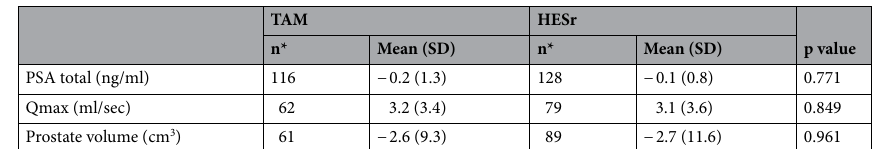
Table 3. Change from baseline to 6-month follow-up in PSA, Qmax and prostate volume for the study groups (iterative matching sample). TAM: tamsulosin; HESr : hexanic extract of Serenoa repens; Qmax: maximum urinary flow rate; PSA: prostate-specific antigen. *Number of patients vary according to the test and the personal clinical practice of the investigators.